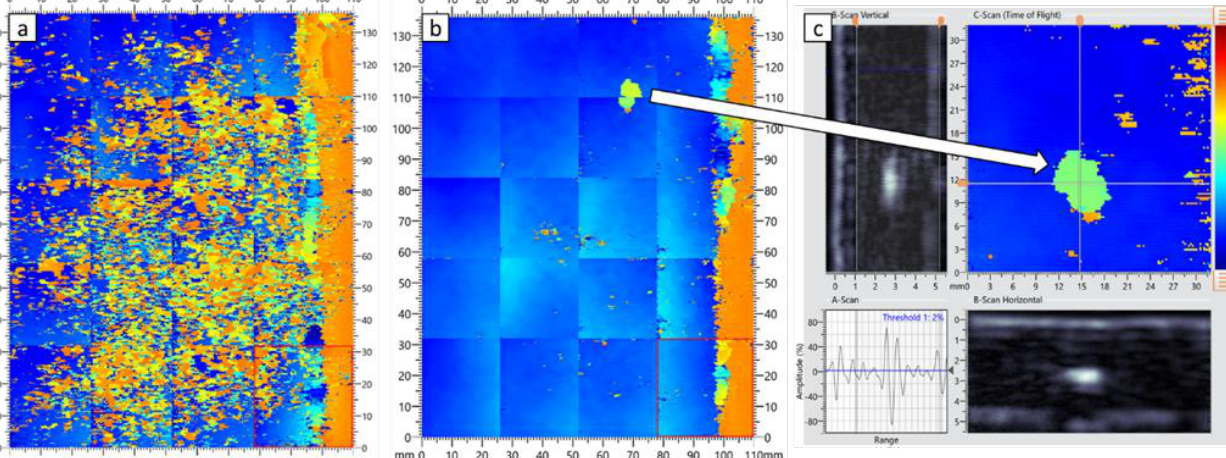
Figure 20. IR thermography pictures of the repaired 3R laminates after impact at 9 J ( left ) and 15 J ( right ). The delaminations of the repaired 3R laminates caused by the second impact test are illustrated in Figure 21.